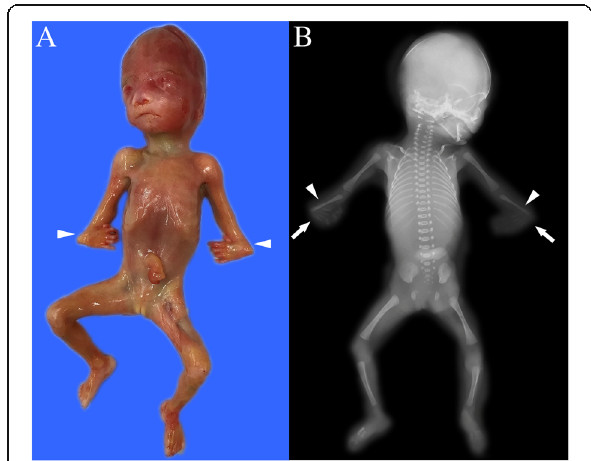
Fig. 1 Case 2: The fetus with trisomy 18 and the absence of the radius. a Gross anatomy of the aborted fetus, showing the bilateral wrist flexion (arrowheads). b X-ray image of the aborted fetus, showing the bilateral bone defects (arrowheads) and bilateral wrist flexion